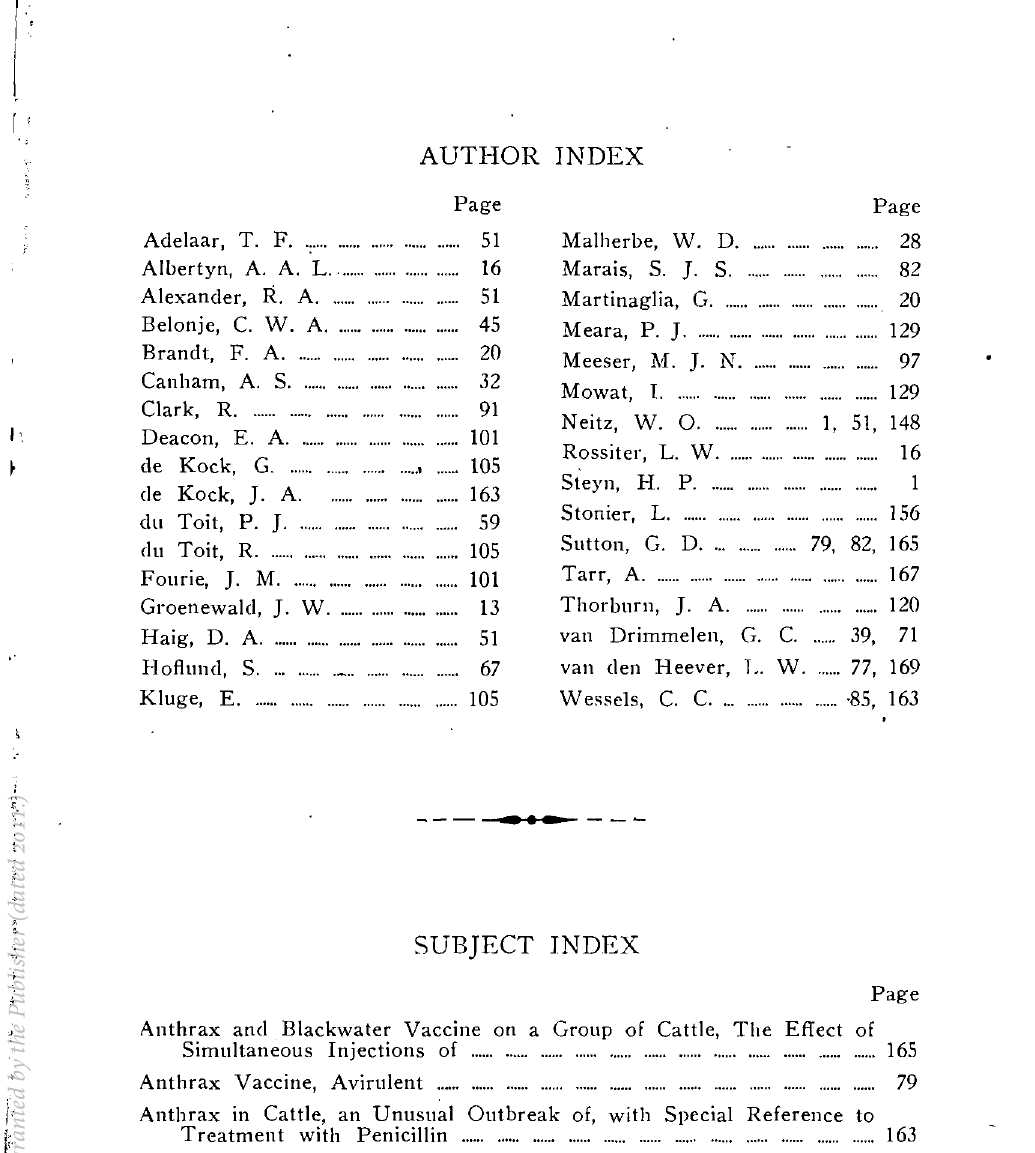
Anthrax and Blackwater Vaccine on a Group of Cattle, The Effect of Simultaneous Injections of ........................................................................ 165 Anthrax in Cattle, an Unusual Outbreak of, with Special Reference to Treatment with Penicillin ........................................................................ 163 Anthrax in a Bull. A Subacute or Atypical Case (Case Report) ...... ...... 71 Babesia canis, the Transmission of to the Black-backed Jackal, with a Discussion on the Classification of the Piroplasms of the Canidae Blackwater Vaccine, The Effect of Simultaneous Injections of Anthrax and - on a Group of Cattle ...... ...... ...... 165 Bluetongue, A Review of the - Brandsiekte, Simon van der Stel on